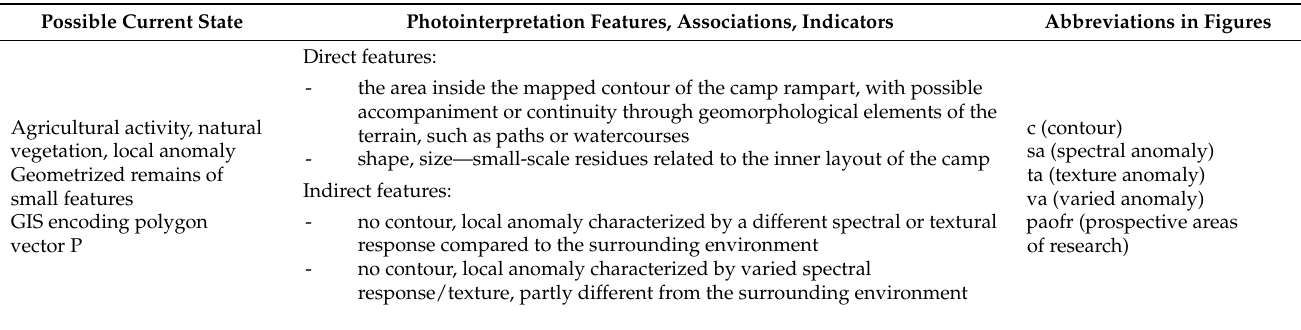
Table 3. Sought-after areal elements and related photointerpretation features anticipated in the satellite imagery. Possible Current State Photointerpretation Features, Associations,